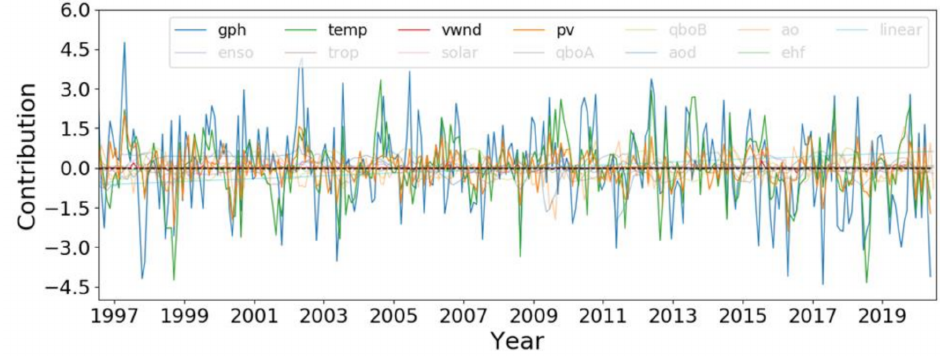
Figure 10. Contributions of atmospheric proxies with emphasized colors from 1997 to 2020 over Pohang from the TOMS/OMI/OMPS satellite-merged